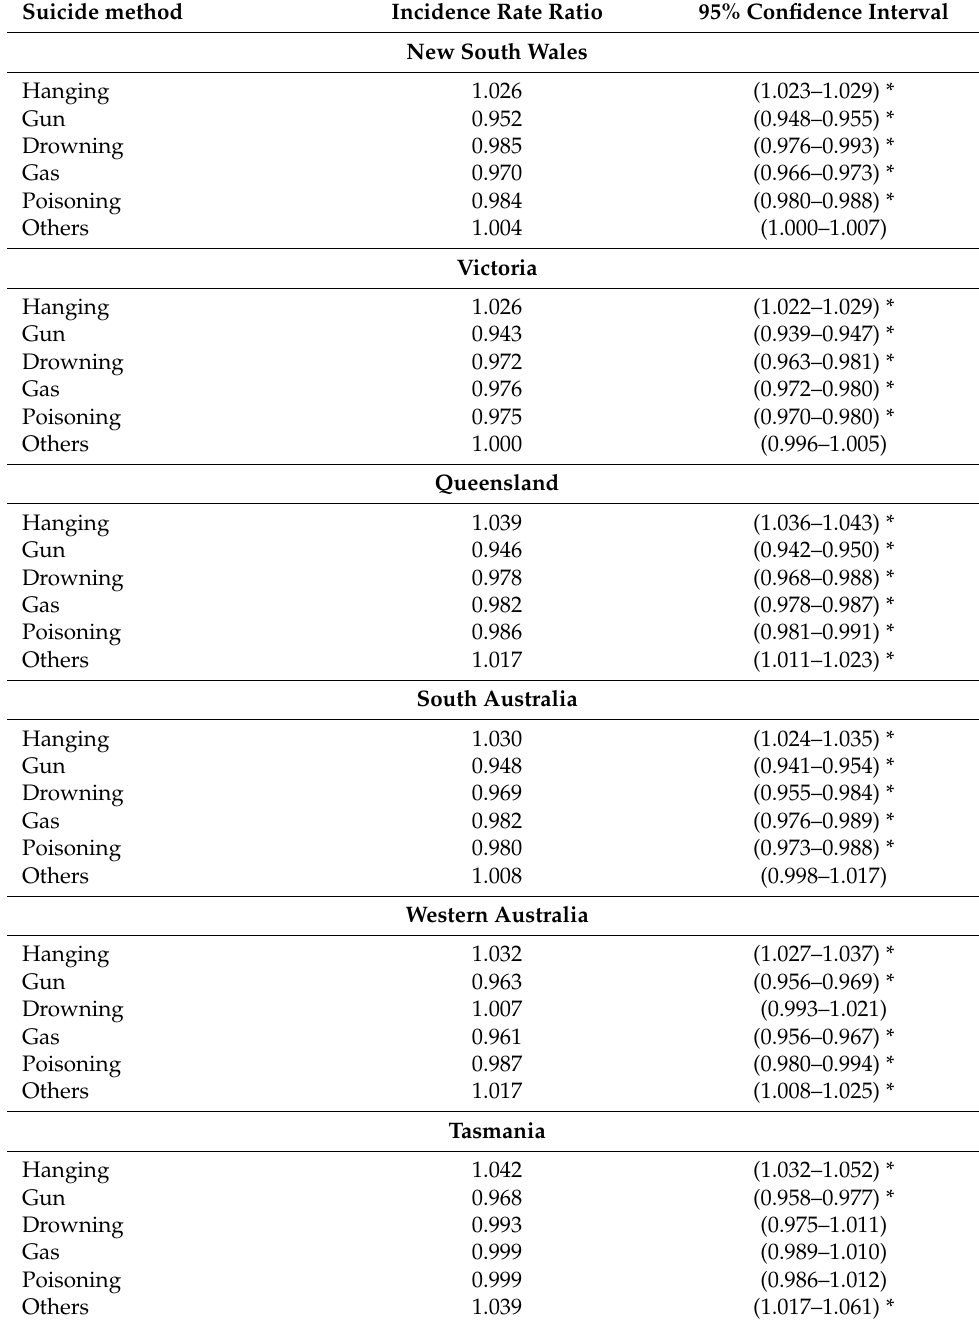
Table 3. Change in mortality trend by suicide method separately by all six